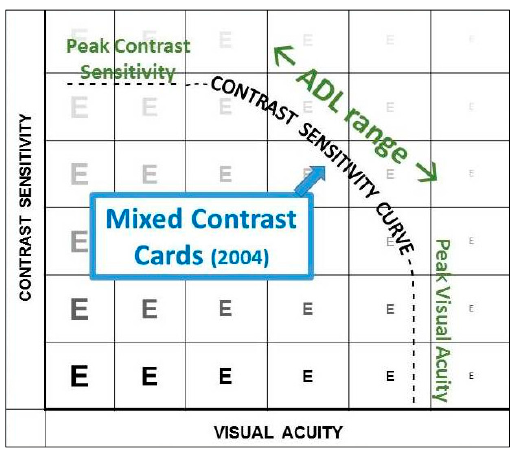
Figure 18. Supra-threshold measurements.